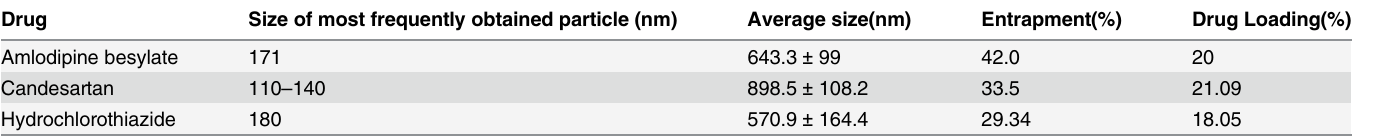
Table 1. Characterization of the optimized nanoparticles (These values are means of a minimum of 5 batches). Drug Size of most frequently obtained particle